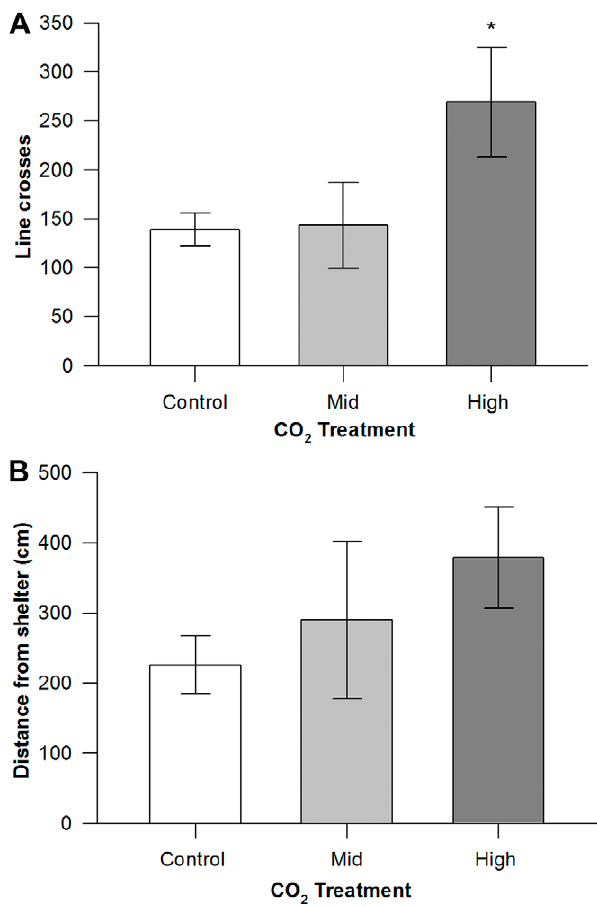
Figure 3. Feeding behaviour of Pseudochromisfuscus . A. Time to respond (seconds; mean 6 SE) and B. feeding strikes (mean 6 SE) of P. fuscus following exposure to control (n=9), mid CO 2 (n=7) and high CO 2 (n=7) water treatments. Significance from planned comparisons (control vs. mid CO 2 ) at p , 0.01=*, p , 0.001=**.